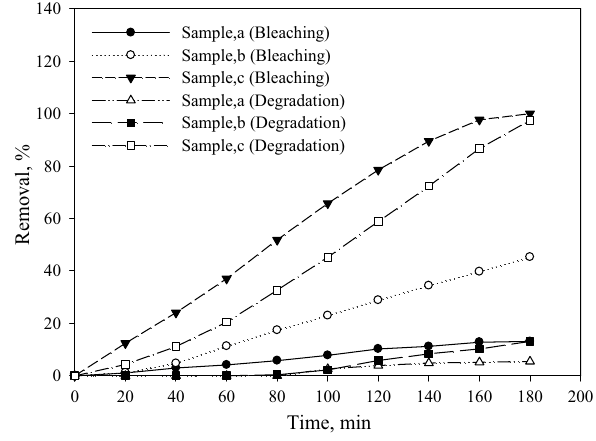
Fig. 12 Effect of precursor concentration on the rate bleaching